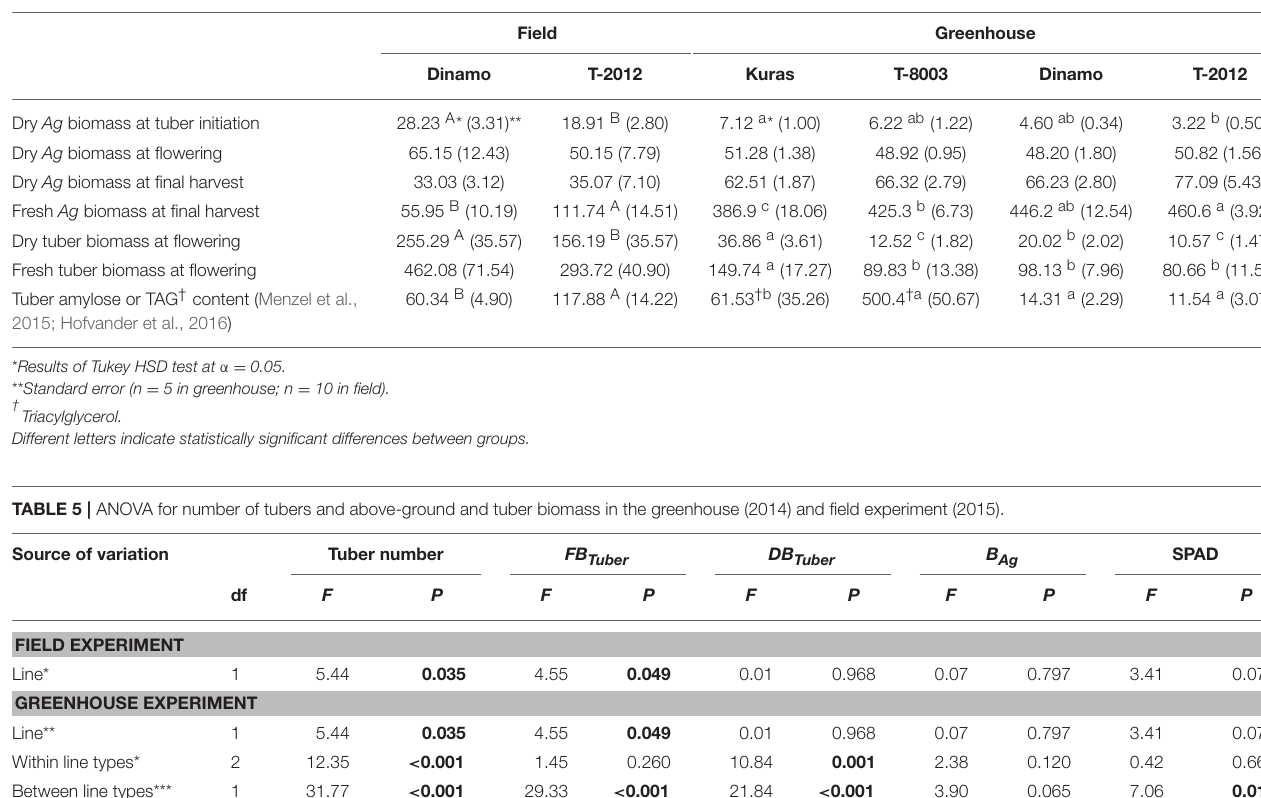
TABLE 4 | Means of dry and fresh above-ground ( Ag ) and tuber biomass (g plant − 1 ) at different developmental stages, and tuber amylose content (g plant − 1 ) in “Dinamo” and “T-2012” and TAG content (nmol plant − 1 ) in “Kuras” and “T-8003,” grown in the field (2015) and greenhouse experiment (2014).